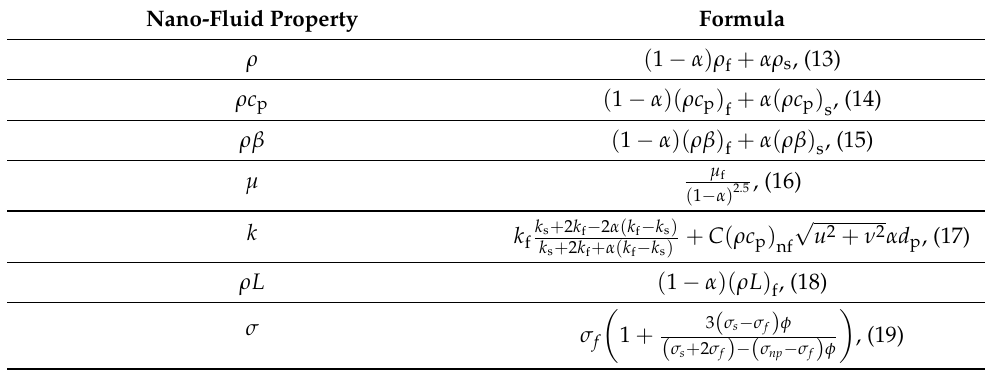
Table 4. Nano-fluid property formulas [4].